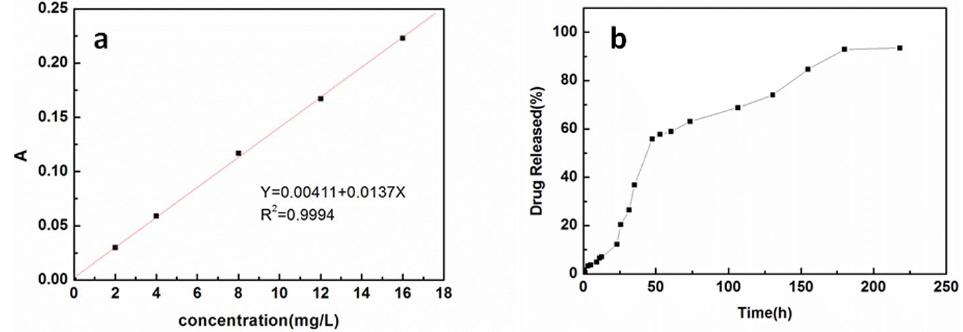
Figure 4. ( a ) Standard curves of ultraviolet (UV) absorption: Niclosamide derivatives at 326.5 nm; ( b ) Drug release behavior of NMD from the NAPD/MM/RF = 1/2/2 hydrogel at 25 °C in water.